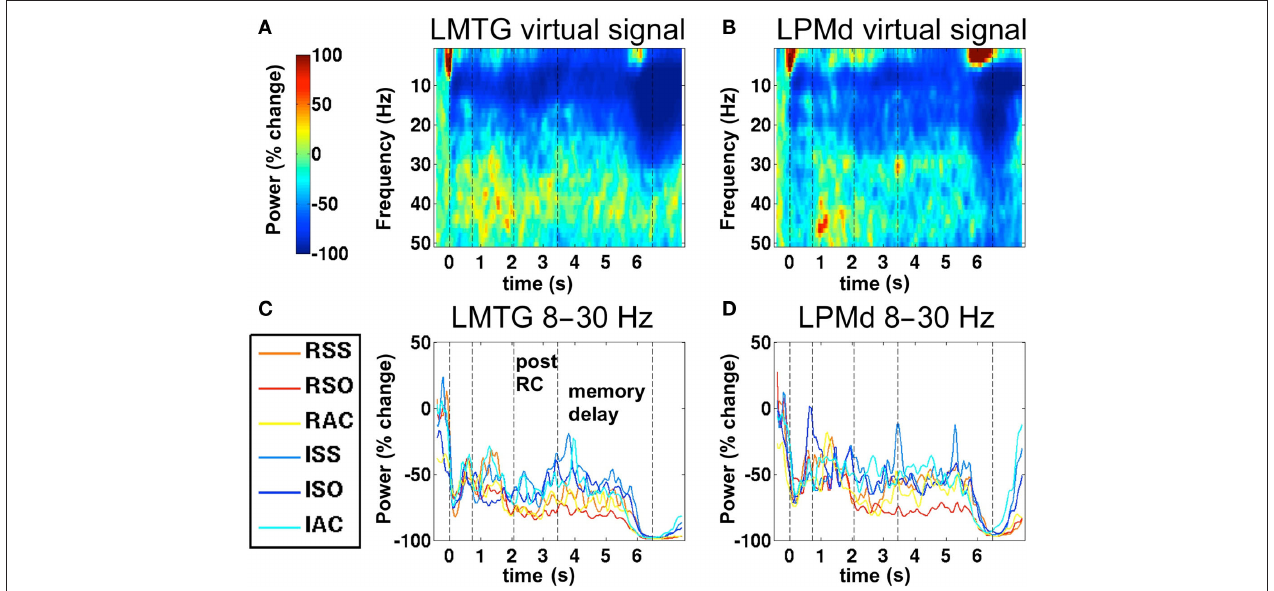
Figure 1B . (B) Time–frequency decomposition of virtual signal extracted from Left Dorsal Premotor cortex (LPMD, Tal. − 44, − 2, + 45). (C) Average timecourse of power in the 8–30 Hz band, in individual conditions, from the virtual signal in LMTG. (D) Average timecourse from virtual signals in